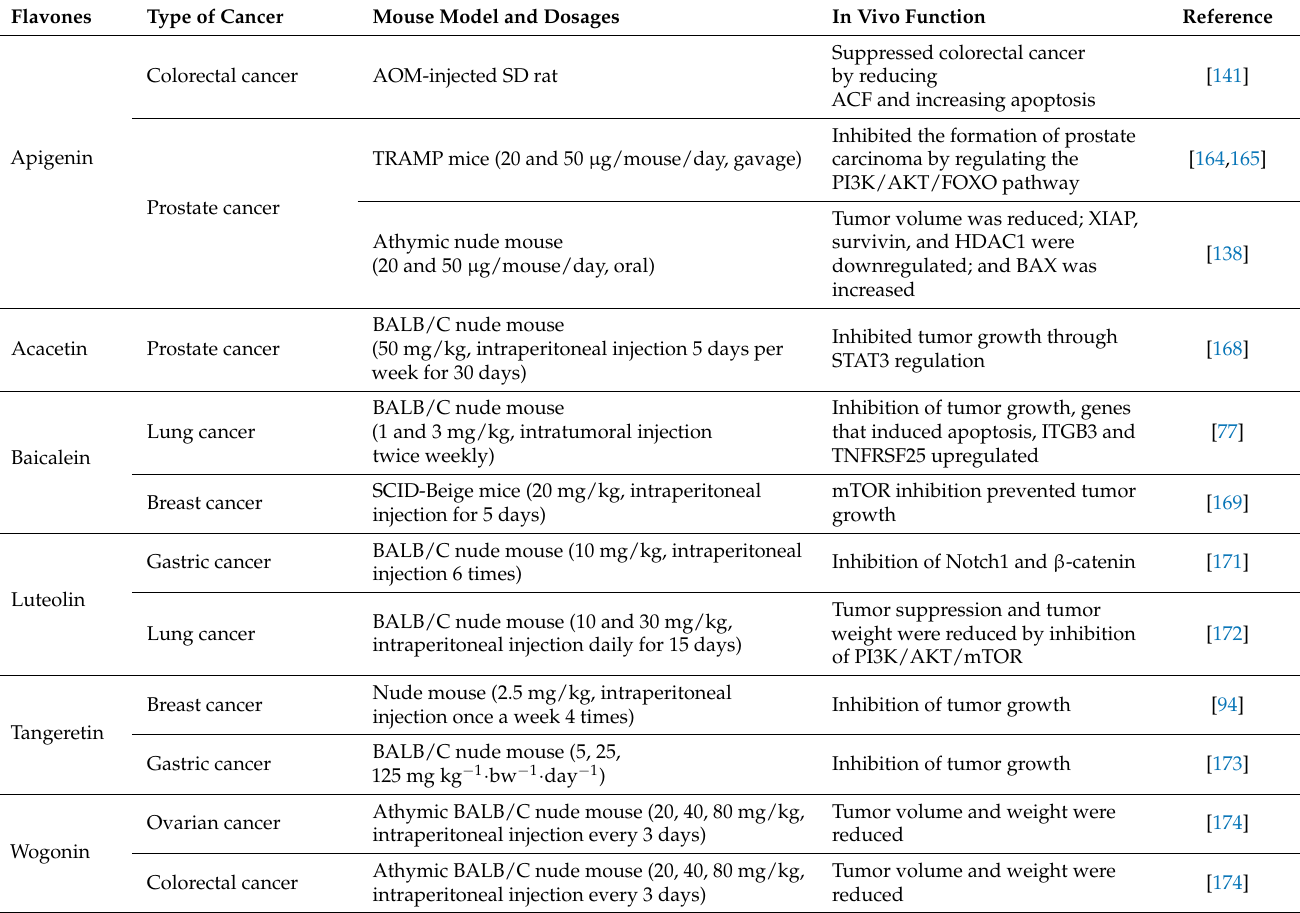
Table 4. Anticancer effects on flavones and in vivo mouse